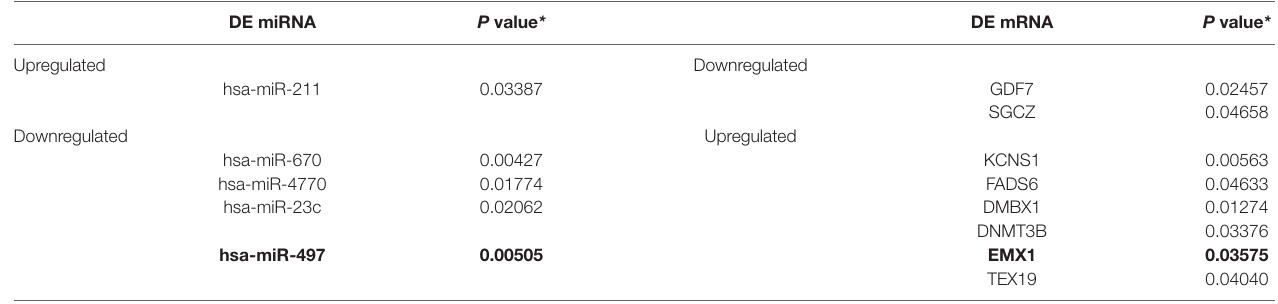
TABLE 1 | DE miRNAs and their potential target DE mRNAs associated with